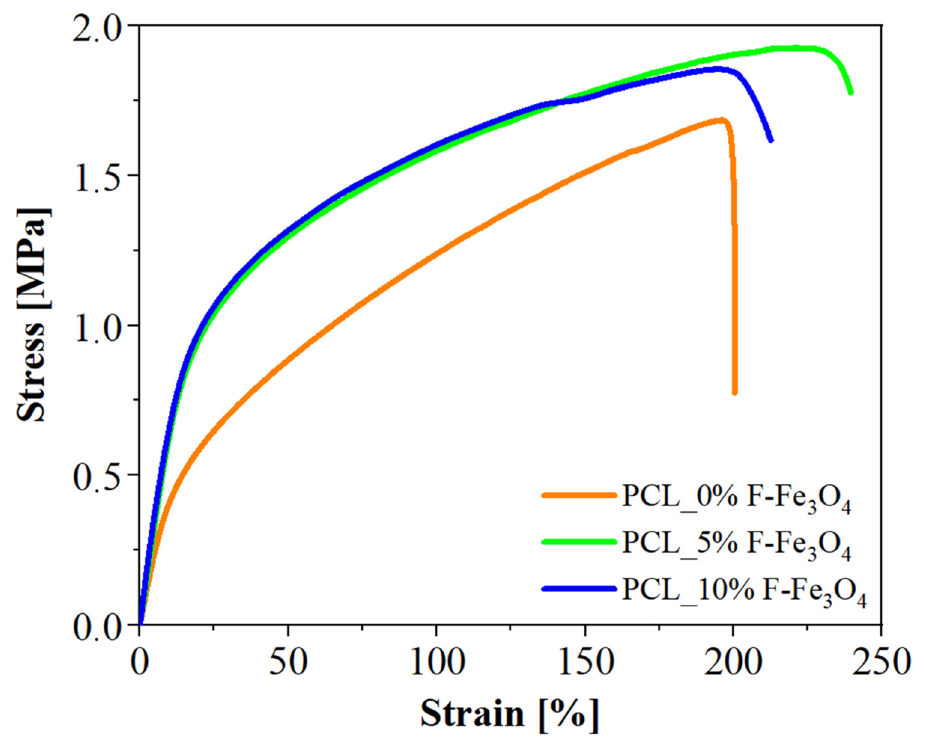
Figure 7. Stress-strain curves of Fe 3 O 4 loaded membranes.